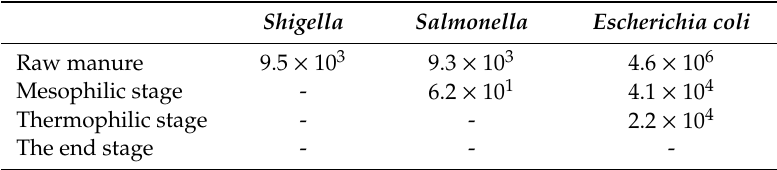
Table 2. Number of pathogenic bacteria per 1 g of compost sample. Table 2 . Number of pathogenic bacteria per 1 g of compost sample .